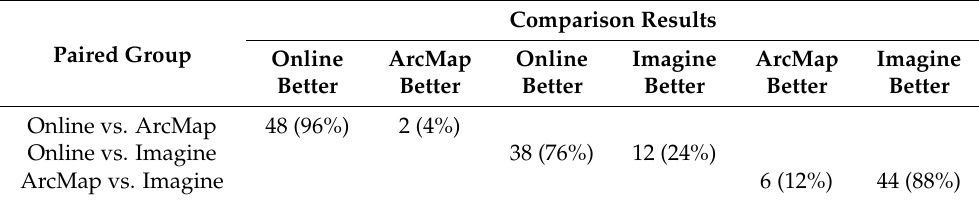
Comparison Results Online ArcMap Online Imagine ArcMap Imagine Better Better Better Better Better Better